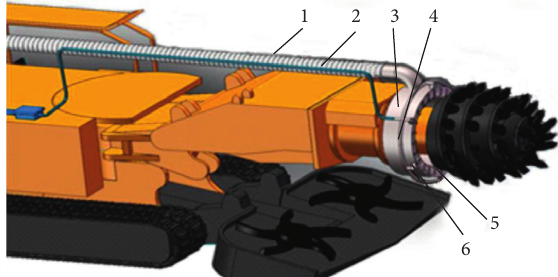
Figure 7: Schematic diagram of device structure ((1) air inlet duct, (2) water supply pipe, (3) ring-mounted air duct, (4) ring-mounted water pipe, (5) high-pressure airflow ejector, and (6)